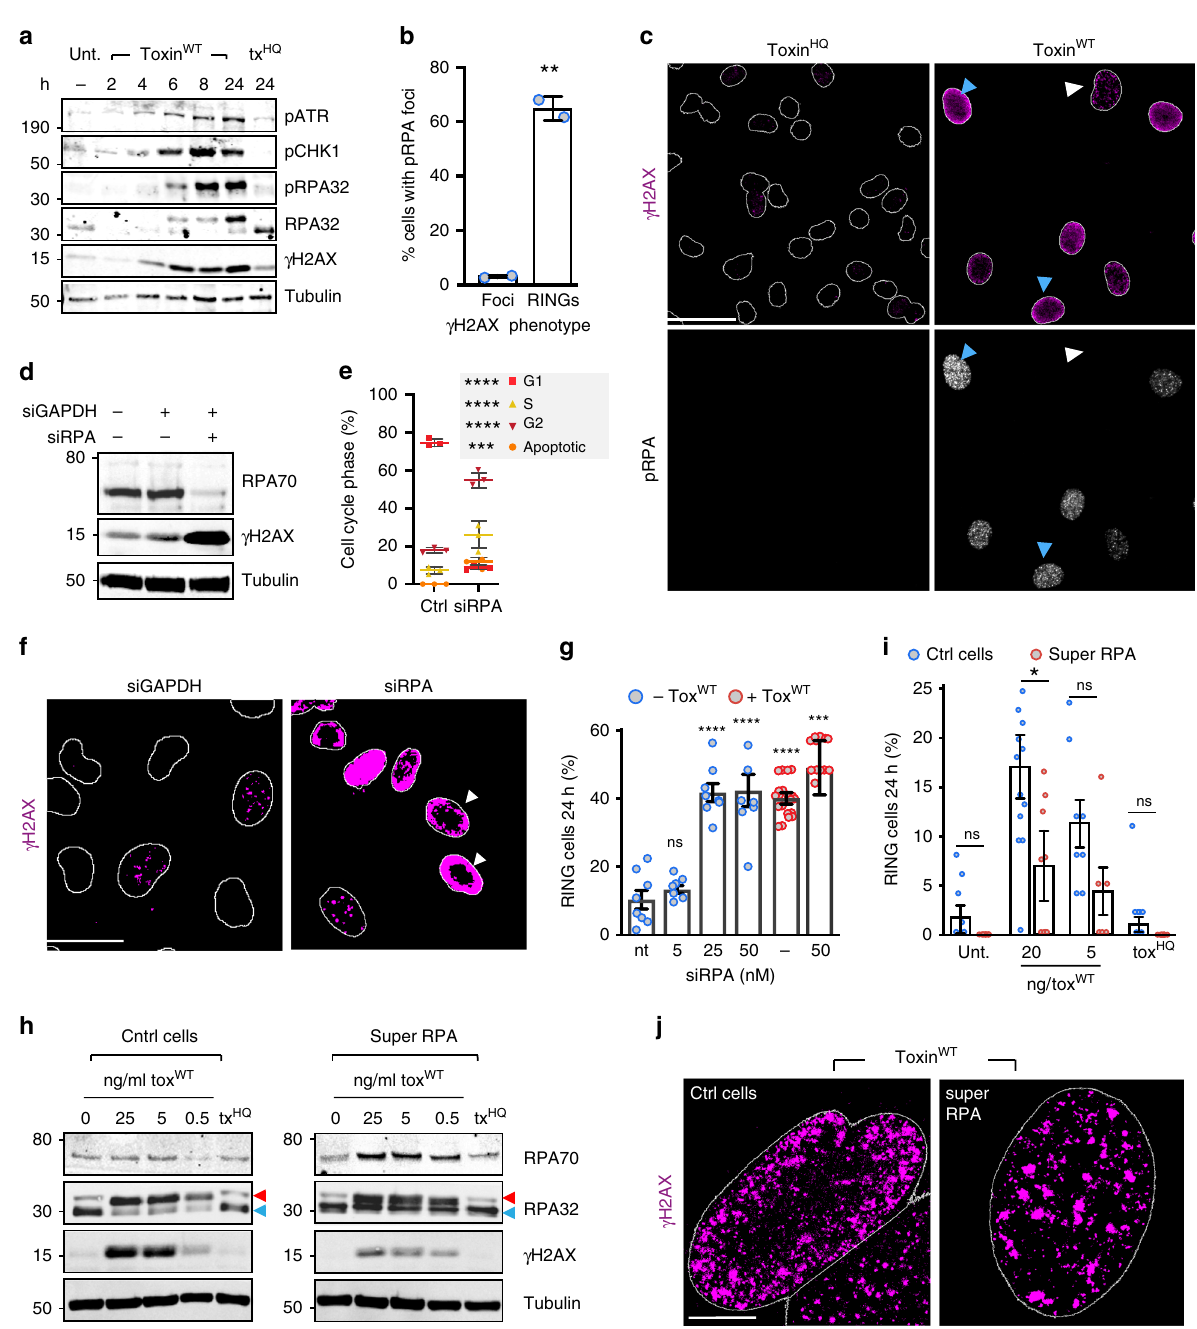
Fig. 3 RINGs mark RPA exhaustion induced by the typhoid toxin. a Representative immunoblot of HT1080 cells intoxicated with toxin WT or toxin HQ (tx HQ ) for 2 h before analysis with indicated antibodies at time-points marked in hours (hr). MW in kDa left. b Proportion of intoxicated cells with γ H2AX RINGs or γ H2AX foci containing RPA pT21 foci (pRPA, grayscale). γ H2AX labelled in magenta. 2 biological replicates (1500 nuclei per variable). Error bars SD. c Representative image of RPA32 pT21 (pRPA) with γ H2AX RINGs (blue arrow) or foci (white arrow). Scale bars 50 μ m. d Representative immunoblot of RPA knockdown (siRPA) cells shown with transfection (siGAPDH) and gel loading (tubulin) controls. In all, 25 nM siRNA for 48 h. MW in kDa left. e Cell- cycle phases in RPA knockdown or siGAPDH control (ctrl) cells. Coloured symbols indicate means from 3 biological replicate (60,000 cells per variable). Error bars SD. f Representative image of γ H2AX RINGs (white arrow) in RPA knockdown cells. Scale bars 25 μ m. g Proportion of γ H2AX RINGs in RPA knockdown cells ± toxin WT . Non-transfected control (nt). Circles indicate means from fi elds of view in two biological replicates (122 nuclei per variable). Error bars SEM. h Representative immunoblot of super-RPA cells ± toxin WT analysed with indicated antibodies. Hyper-phosphorylated RPA32 (red arrow), non-phosphorylated RPA32 (blue arrow). MW in kDa left. i Proportion of γ H2AX RINGs in super-RPA cells ± toxin WT . Two biological replicates (2000 nuclei per variable). Error bars SEM. j Representative image of γ H2AX in U2OS control cells (ctrl) or super RPA U2OS cells stably expressing recombinant RPA complex intoxicated with 5 ng/ml toxin WT . Scale bars 5 μ m. In representative images c , f , g outlines of DAPI-stained nuclei are shown.